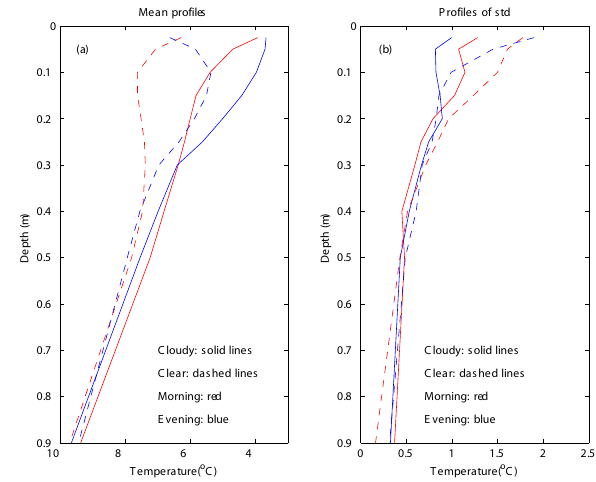
Fig. 4. Mean profiles of (a) snow temperature and (b) day-to- day standard deviation of snow temperature near Basen nunatak, averaged over the two summers but calculated separately for cloudy mornings (13 days), clear mornings (15 days), cloudy evenings (12 days), and clear evenings (15 days).